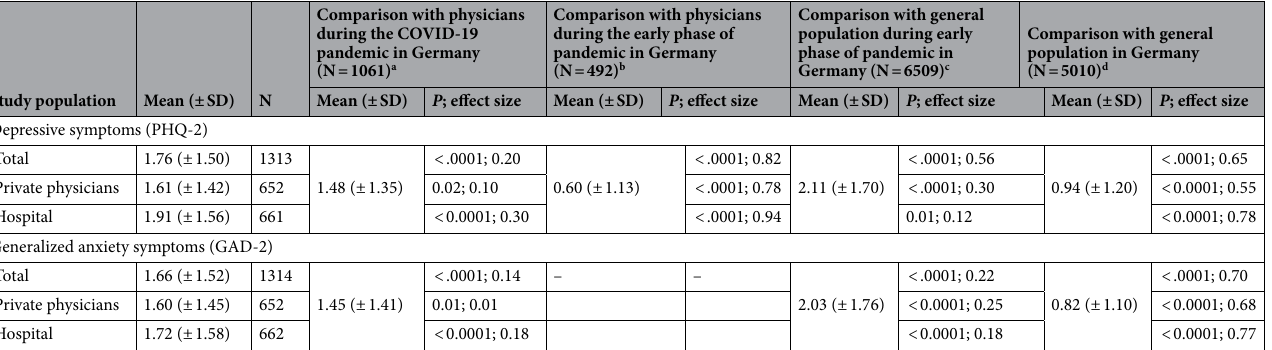
Table 3. Severity of depressive symptoms (PHQ-2) and generalized anxiety symptoms (GAD-2) for physicians in private practice and hospital settings, in comparison with general population and reference groups before and during the COVID-19 pandemic. a Morawa et al. 21 . b Skoda et al. 22 . c Petzold et al. 23 . d Löwe et al. 24 . *Mean (± SD) and pairwise comparison, P values; effect size Cohen’s d; d ≥ 0.2 = small, d ≥ 0.5 = medium and d ≥ 0.8 = large effect size.